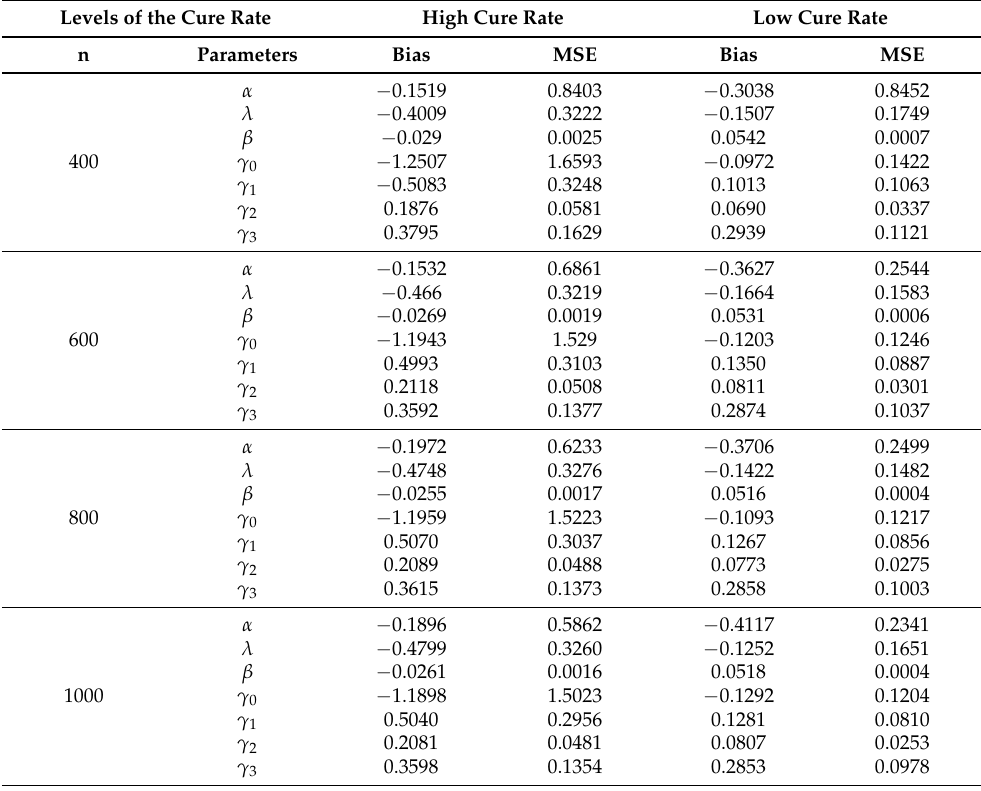
Table 6. Simulated bias of the ML estimators of the parameters and their corresponding MSE in the simulation studies with